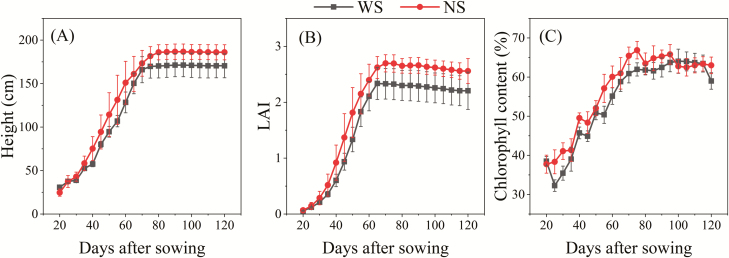
Mean height, (B) leaf area index (LAI), and (C) relative chlorophyll content of water-stressed (WS) and non-water stressed (NS) summer maize. Data points are mean values obtained from a set of five plant samples; error bars represent ±1 SD.